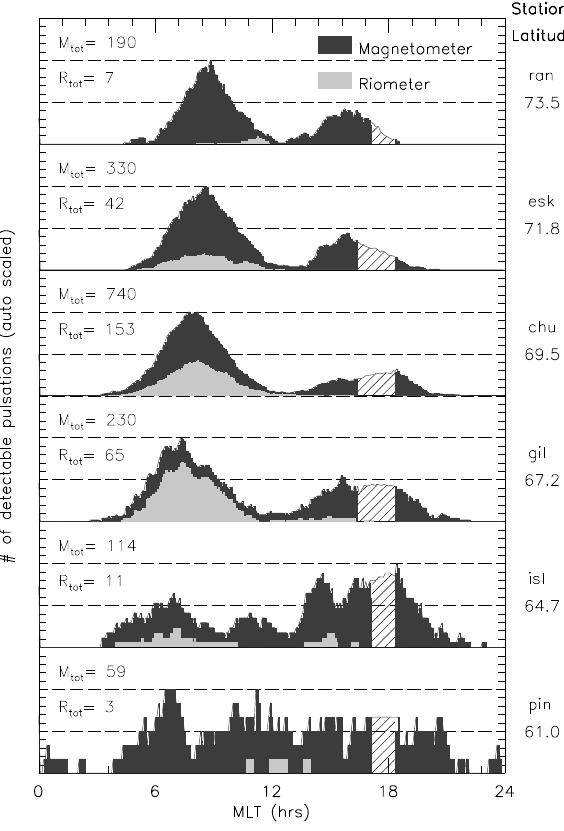
Fig. 4. Modified Pc5 Distribution from Baker et al. (2003) and the corresponding riometer pulsations (auto scaled). Magnetic pulsa- tions are shown in dark grey and those which have a concurrent riometer pulsation are shown in light grey.